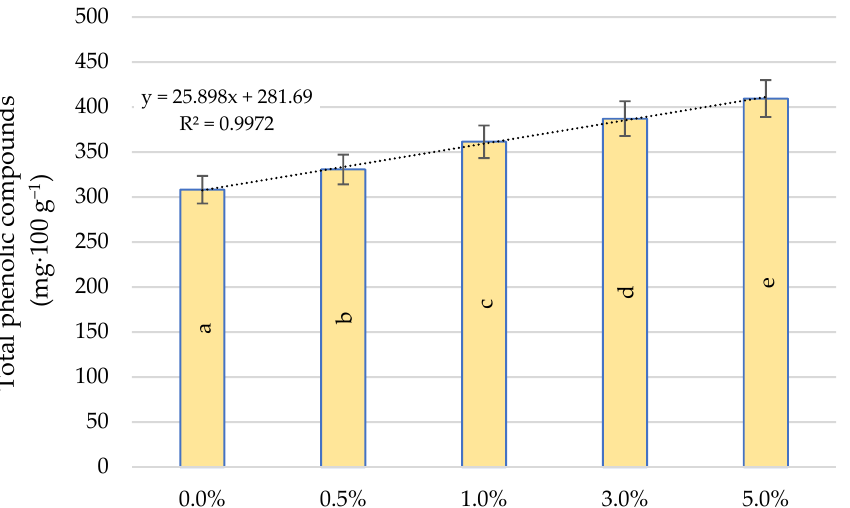
Figure 7. Effect of quercetin derivative concentrations on total phenolic compounds. Different letters indicate significant differences between each quercetin derivative concentrations, according to ANOVA (followed by Tukey’s HSD test, p = 0.05).